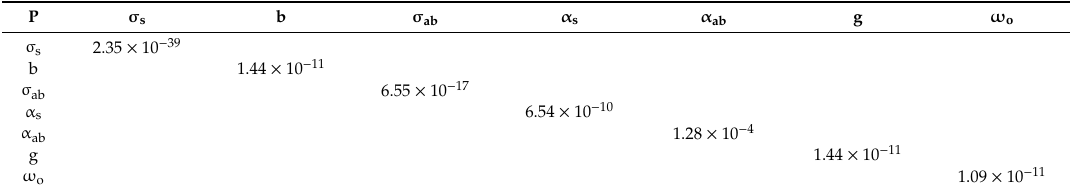
Table 5. The results of the Kolmogorov-Smirnov test each aerosol optical